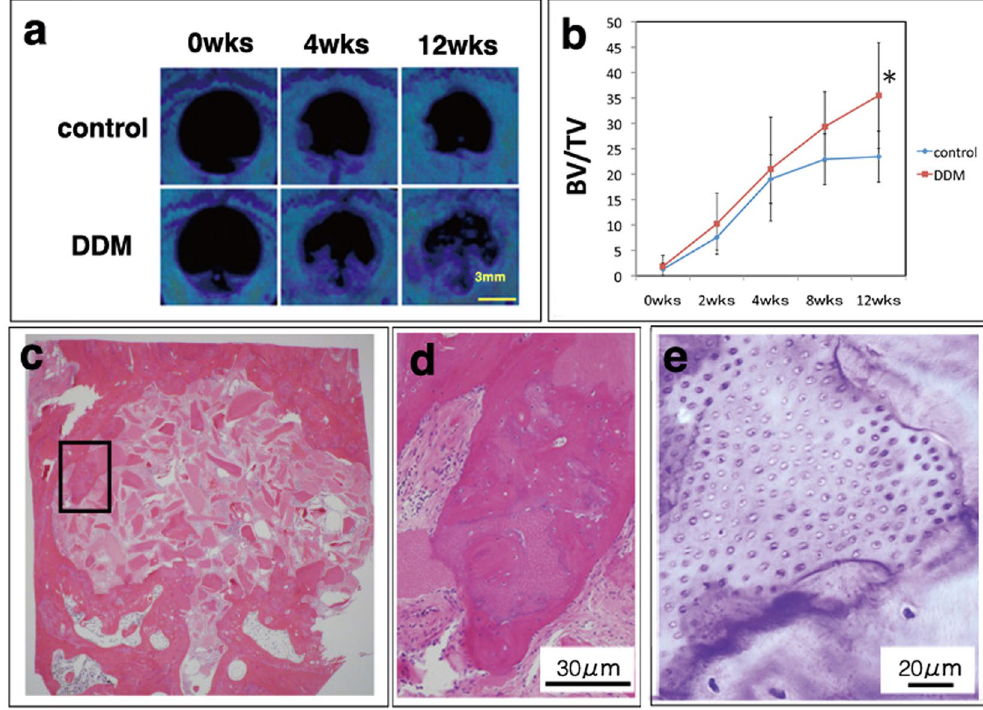
Figure 2. Computed tomography assessment and light micrographs. ( a ) At 0 weeks, no radiopacity was visible in the defect regions in the demineralised dentin matrix (DDM)-implanted and control groups. Over 12 weeks, the defect region showed increasing radiopacity in the DDM-implanted group. ( b ) The bone volume/total defect volume (BV/TV) increased incrementally. At 12 weeks, there was a significant difference. ( c ) The horizontal plane of the defect area in the DDM group at 12 weeks. ( d ) Higher magnification of the square area in panel (c). Newly formed bone tissue with the DDM as the core is visible in the haematoxylin and eosin stained sections from the DDM-implanted group. ( e ) A serial section of the image in ( d ). Solid red–purple matrices of the dentinal tubules are visible in the toluidine blue-stained